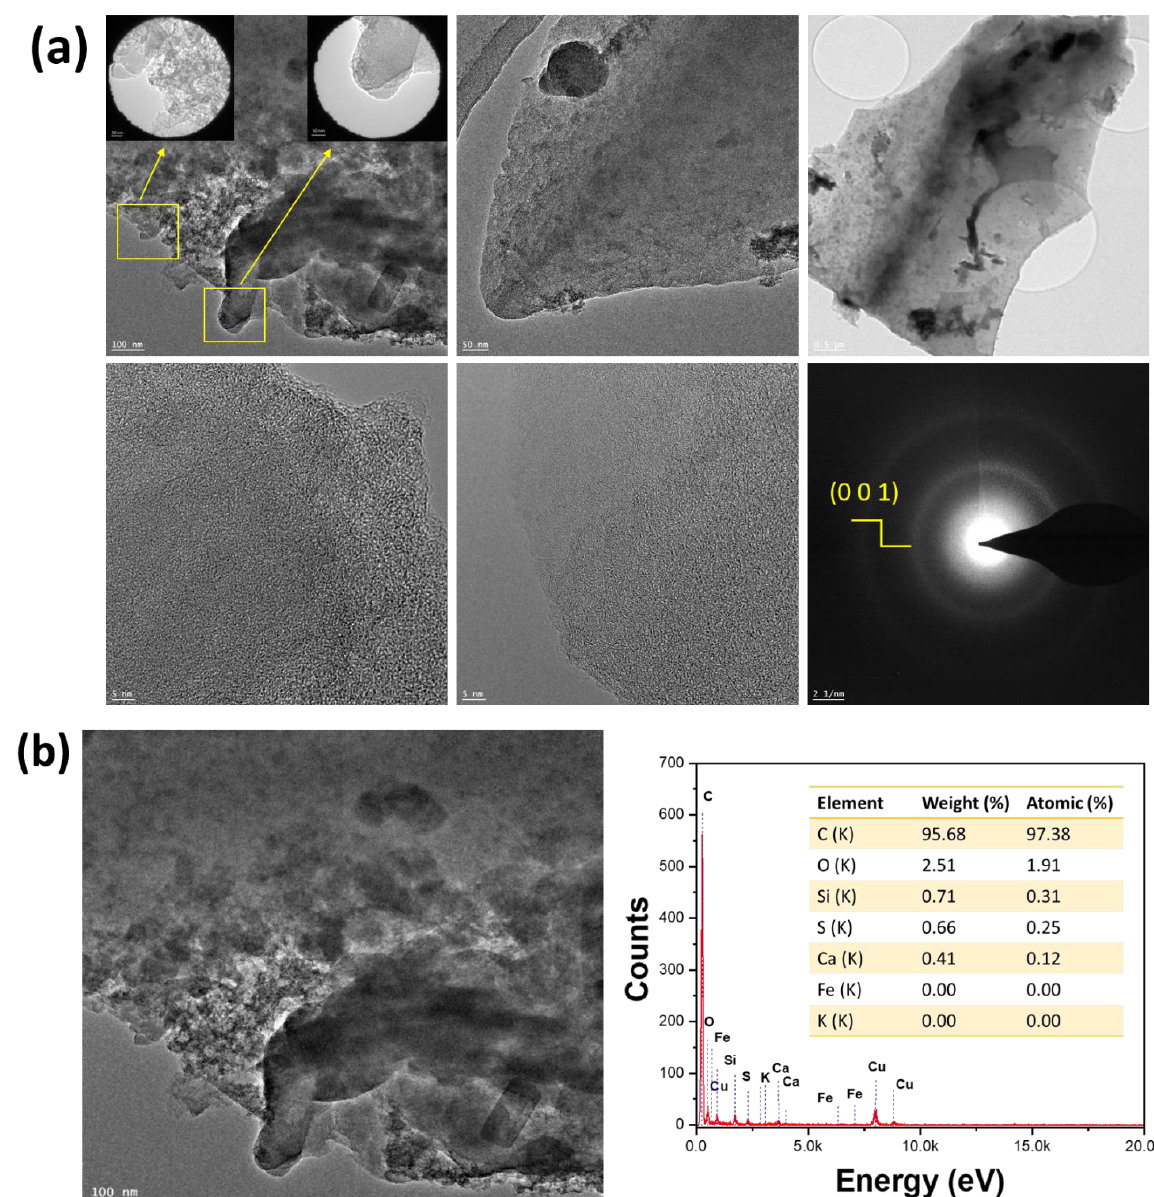
Figure 6. ( a ) TEM images of GO with SAED pattern, ( b ) elemental analysis. GO has a number of oxygen-containing functional groups which are covalently bonded to a graphene basal plane and edges with a C/O atomic ratio of 4.46. It creates a strong hydrophilic characteristic that disperses well in water